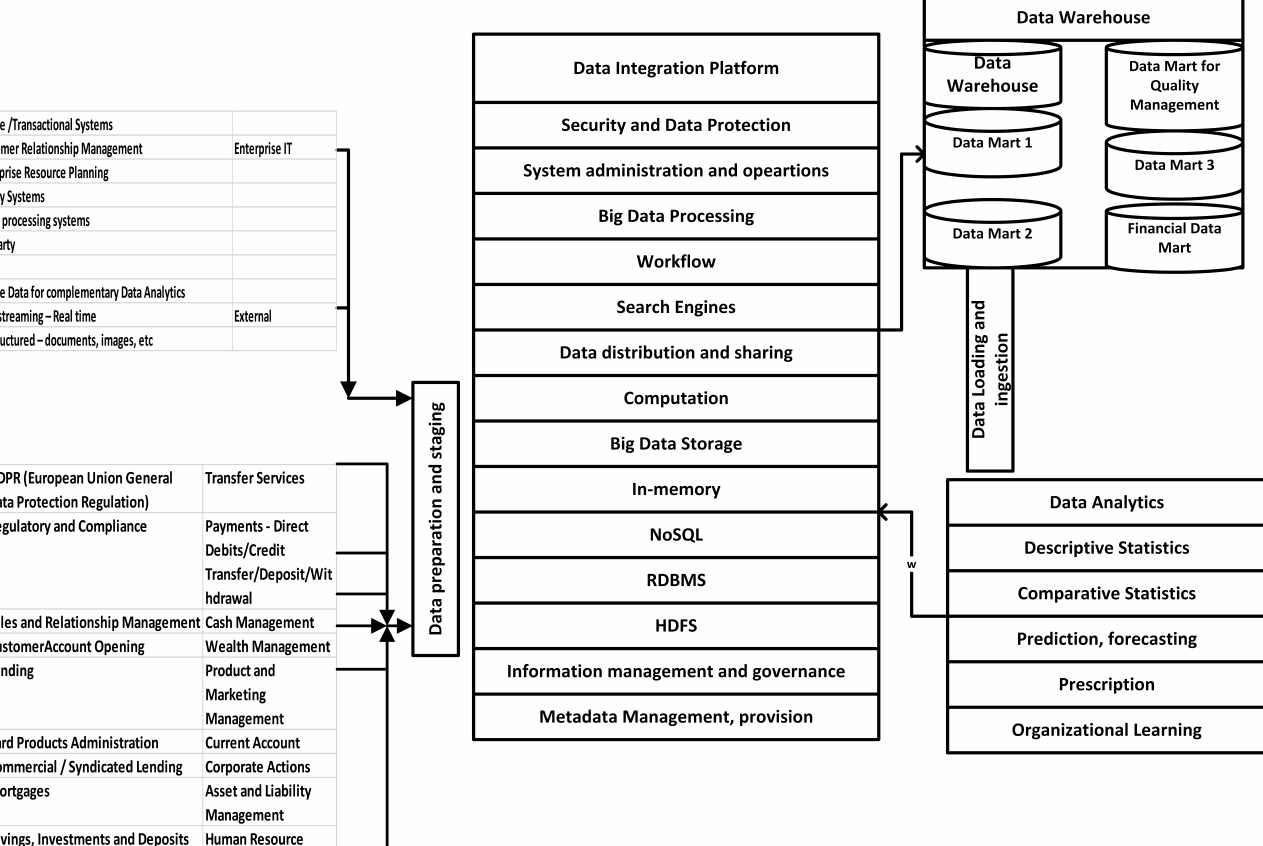
Figure 3. Data lake and analytics components architecture for a financial services technology company a . a On the left-hand side, we list the necessary modules for an operating company and services that are specific to financial institutions; in the middle, we show the services of Information Technology and Infrastructure Management that are essential for data processing and data analytics; in the bottom-right corner, the techniques for the data analytics can be seen; while in the top-left corner, we describe an active symbiosis between the architecture of the data lake and data warehouse/mart. Sources for creating the figure were from